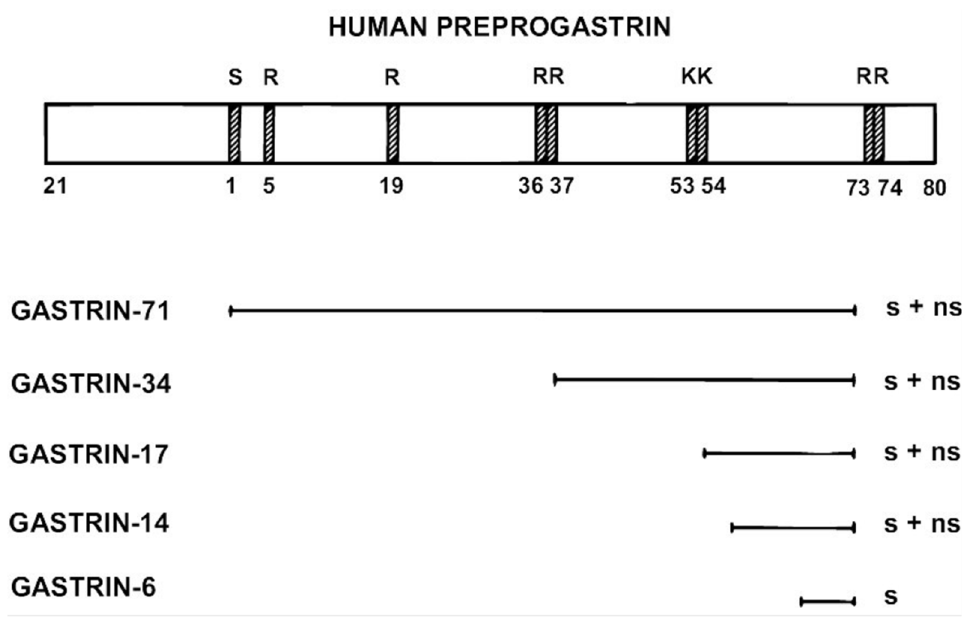
Figure 3. Scheme of carboxyamidated products of preprogastrin. Endoproteolytic cleavage sites (R and K) are shown on preprogastrin. S and ns mean “sulfated” and “non-sulfated”, respectively.